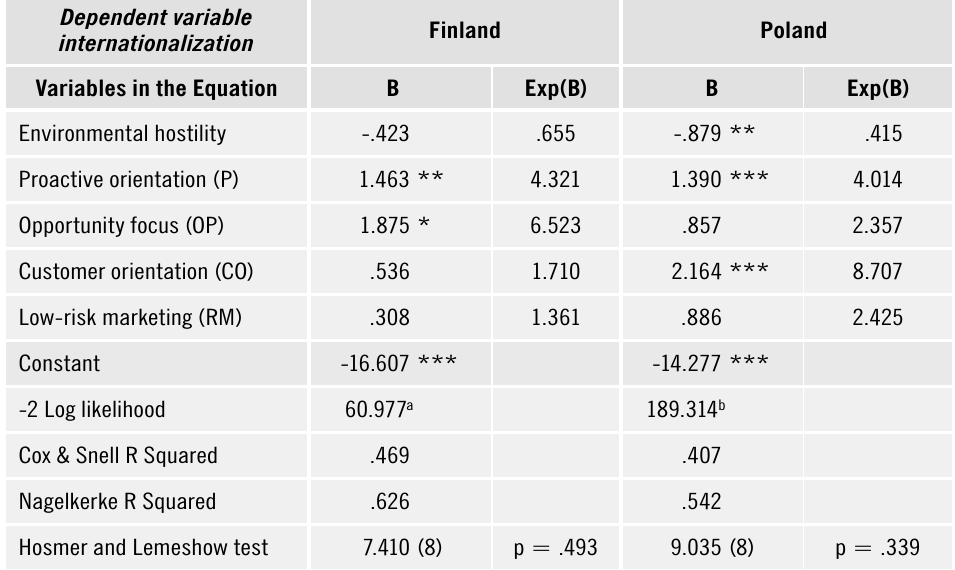
Table 7. Logistic regression model of